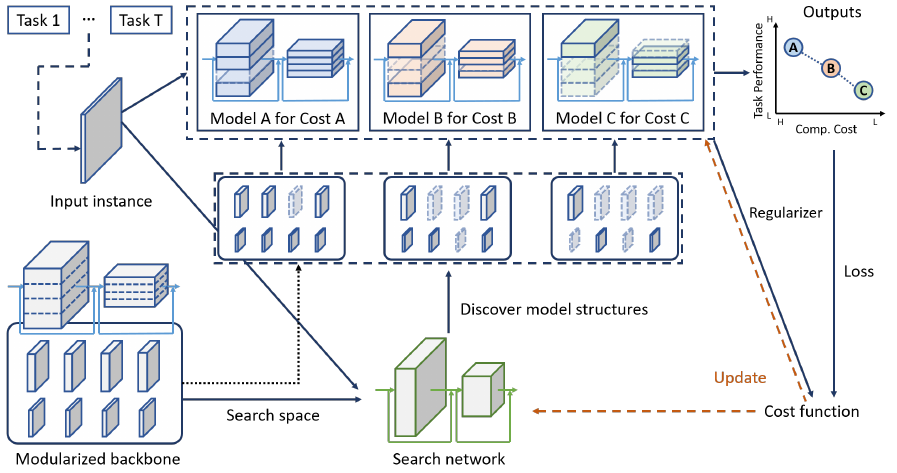
Figure 2. Overall framework of the proposed method which consists of two major components: backbone and search networks. The proposed method updates the parameters (orange dotted lines) for the chosen models in the backbone and the search network by considering both task performance (loss) and computational cost (regularizer). The chosen models have trade-offs between task performance and computational cost shown in the top